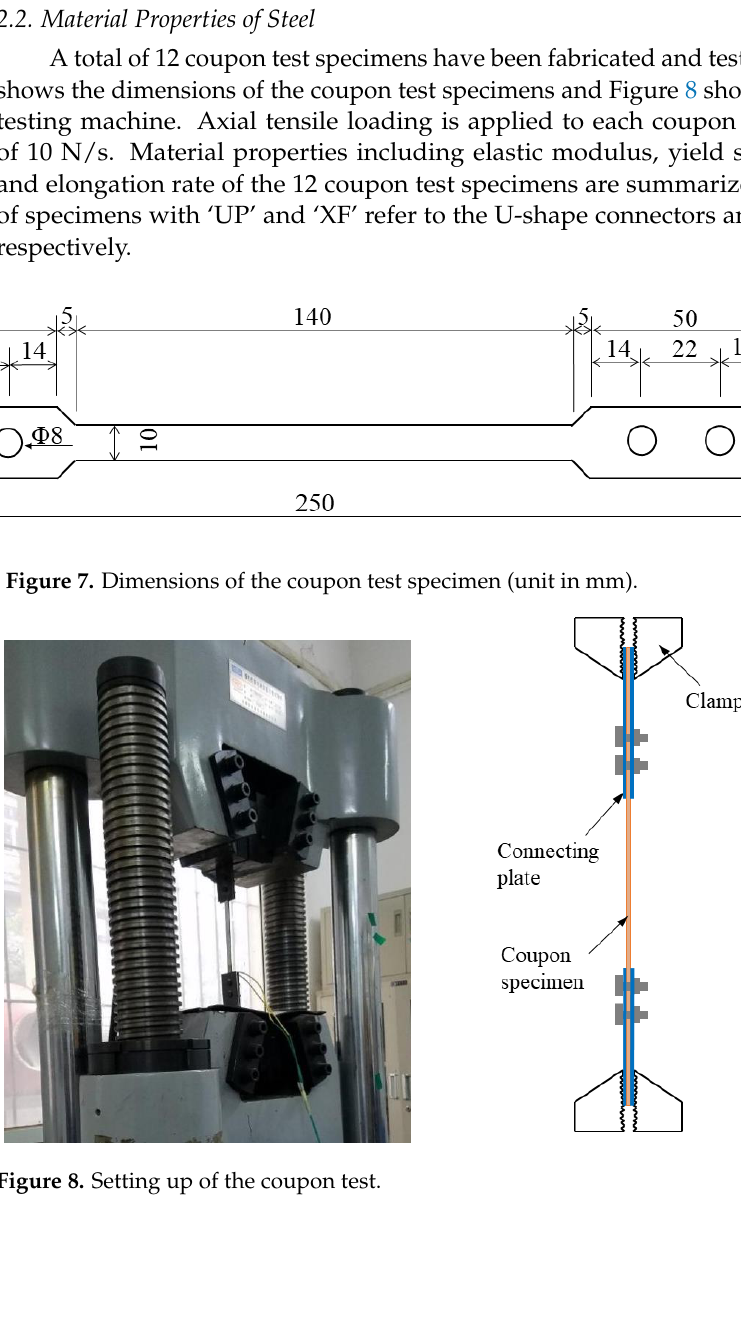
Figure 6. A completed K-joint specimen.